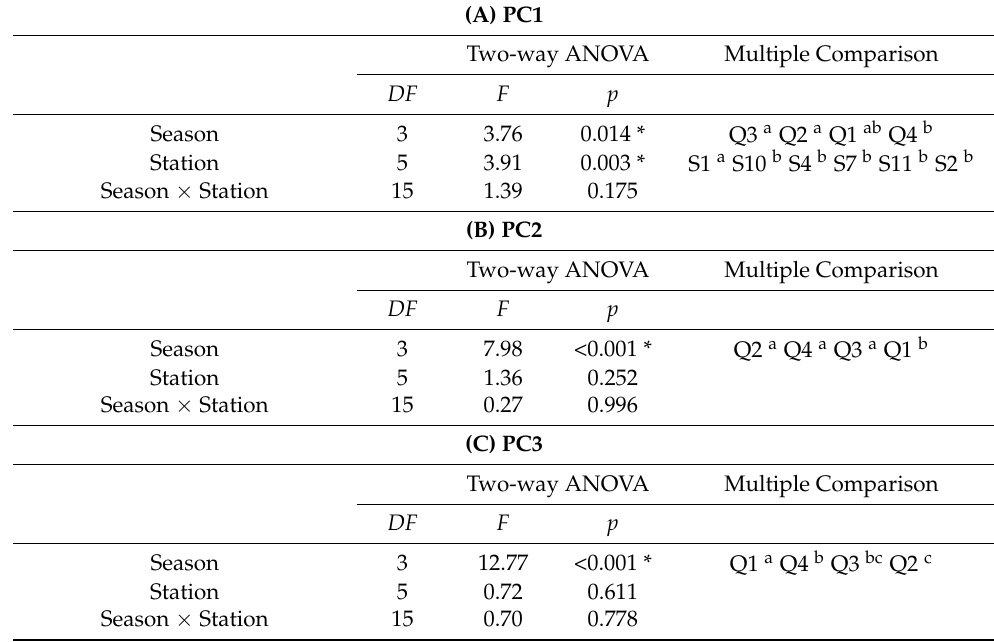
Table 3. Results from two-way ANOVA tests and all pairwise multiple comparisons (Tukey’s HSD Test) on principal components 1 to 3. * p < 0.05. Different superscripts indicate significant